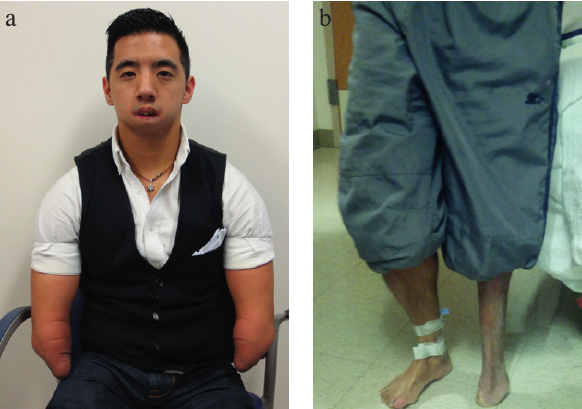
Fig. 2. a (left), b (right) : Transverse deficiencies of the upper extremity below the elbow (left) and an absent foot below the upper ankle of the left lower extremity (right).